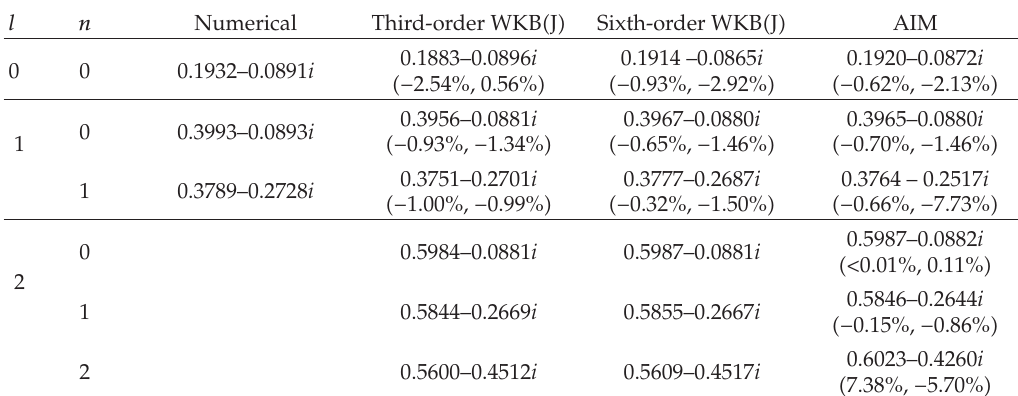
Table 10: The QNM frequencies for the spin half perturbations of the Kerr black hole, with a (cid:8) 0 . 80 (cid:2) M (cid:8) 1 ,m (cid:8) 0 (cid:3) . Numerical data via the CFM were taken from (cid:5) 48 (cid:6) , where the AIM was set to run at 15